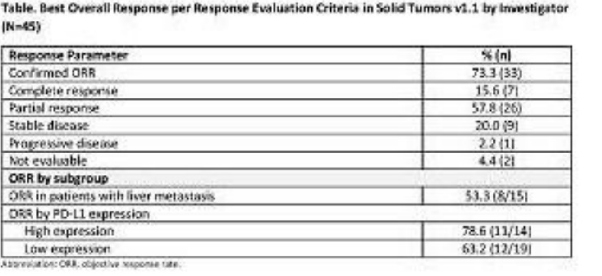
Table. Best Overall Response per Response Evaluation Criteria in Solid Tumours v1.1 by Investigato